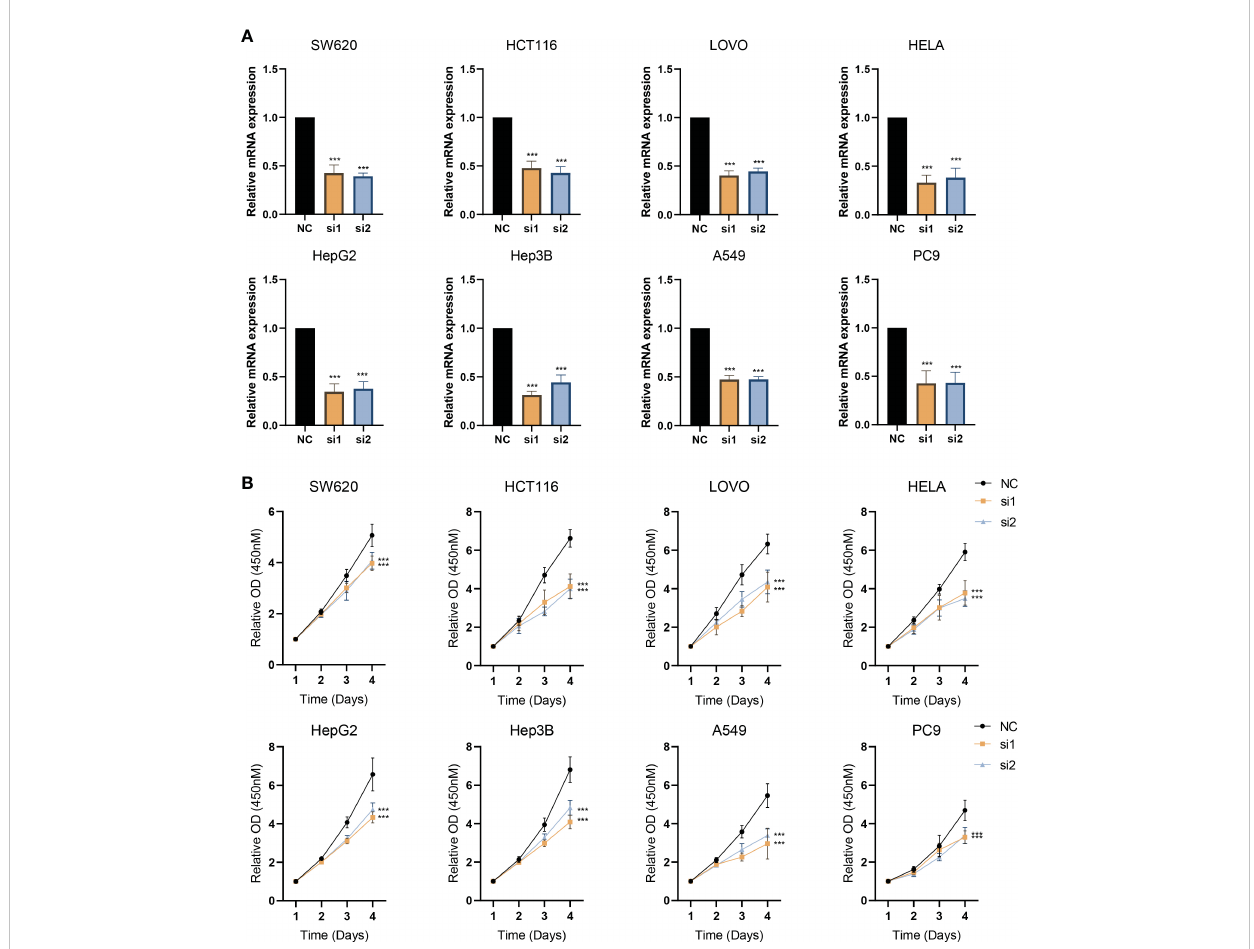
FIGURE 9 Interference with ESPL1 expression inhibits cell proliferation in a variety of cell lines. (A) Validation of siRNA interference ef fi ciency. (B) Cell proliferation curves following interference with ESPL1 expression in eight different cell